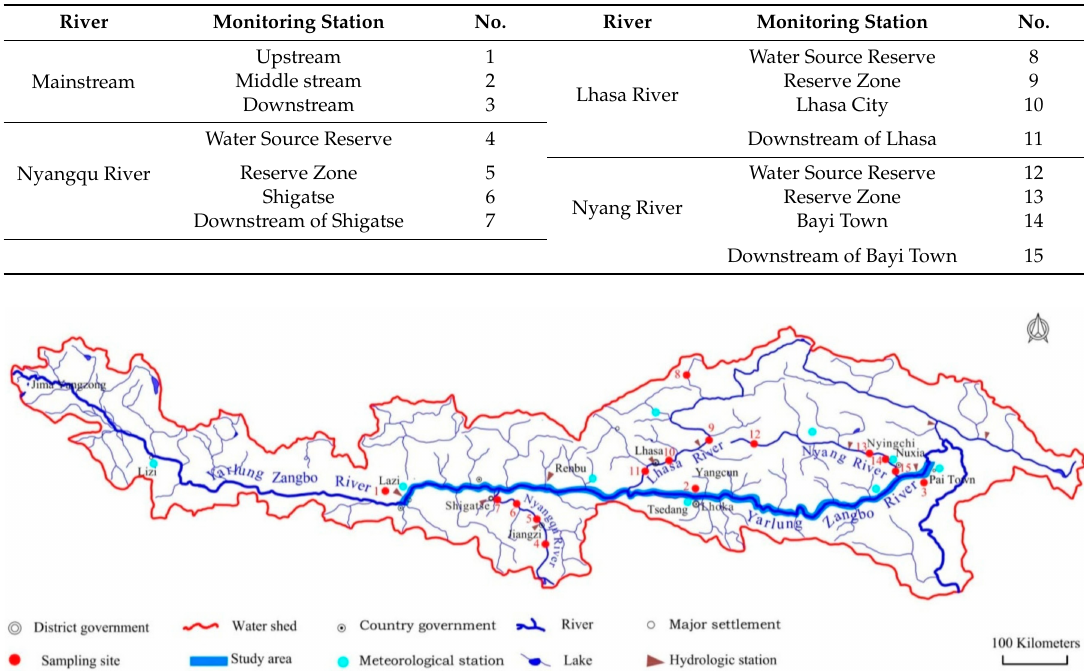
Figure 1. Water system of the Yarlung Zangbo (YLZB) River